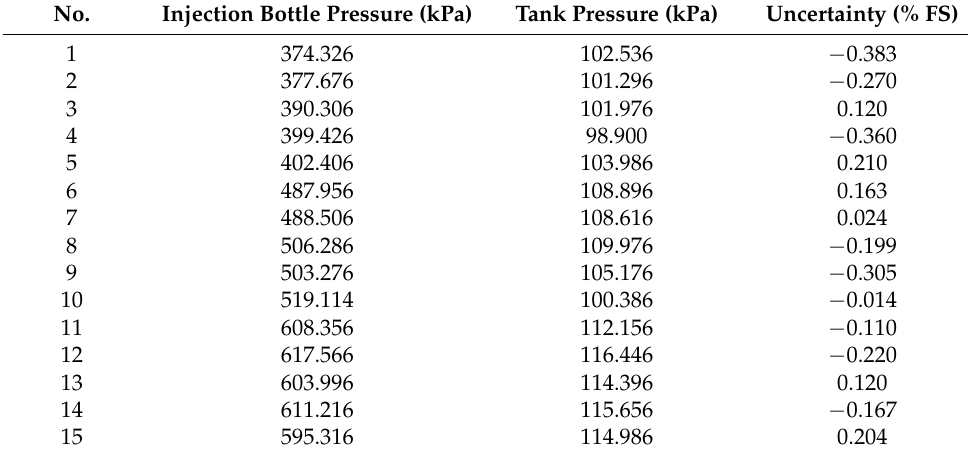
Table 2. Measured mass